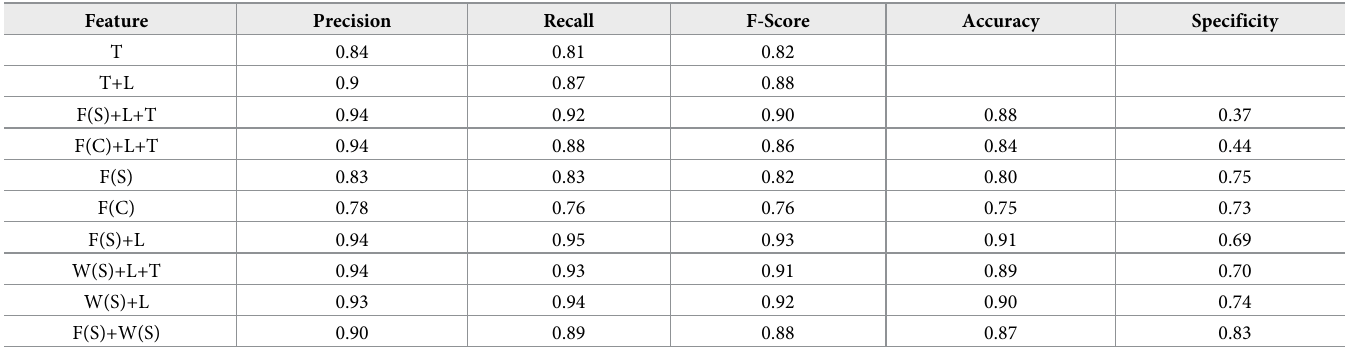
Table 7. Performance of the GBM binary classifier on the combined corpus. Feature